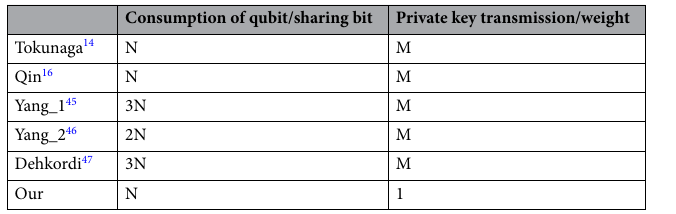
Table 1. The cost of single dimensional quantum